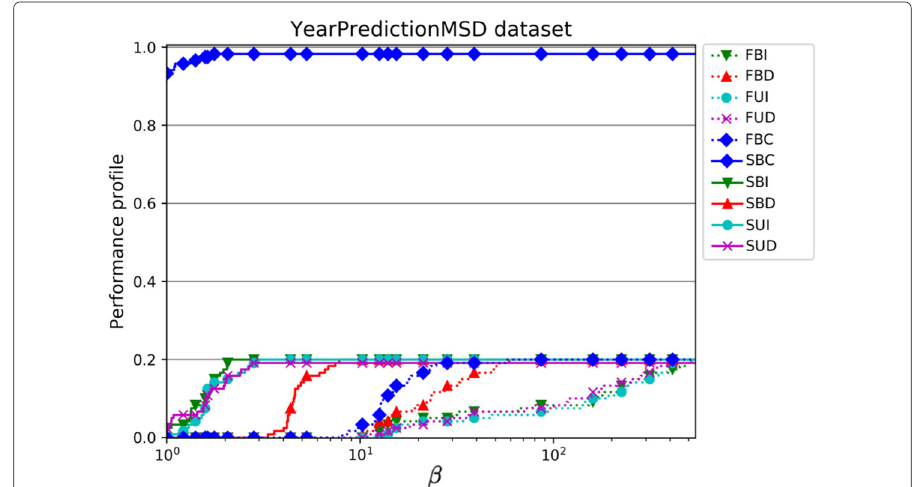
Fig. 16 Performance profile for all 10 methods, for the tests perfomed on the YearPredictionMSD data